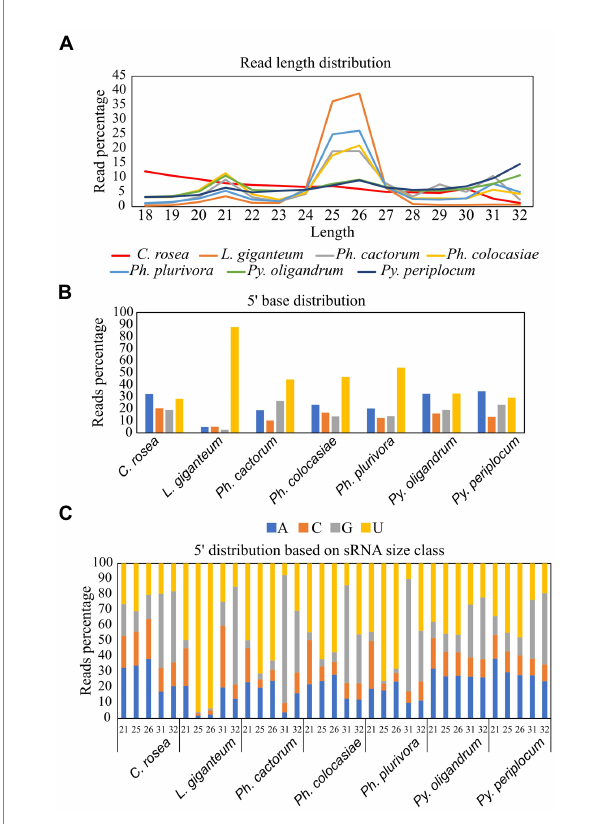
FIGURE 3 Characteristics of sRNAs identified in Pythium spp., Phytophthora spp., Clonostachys rosea and Lagenidium giganteum. (A) Read length distribution. (B) 5 ′ base distribution. (C) 5 ′ base distribution based on sRNA size